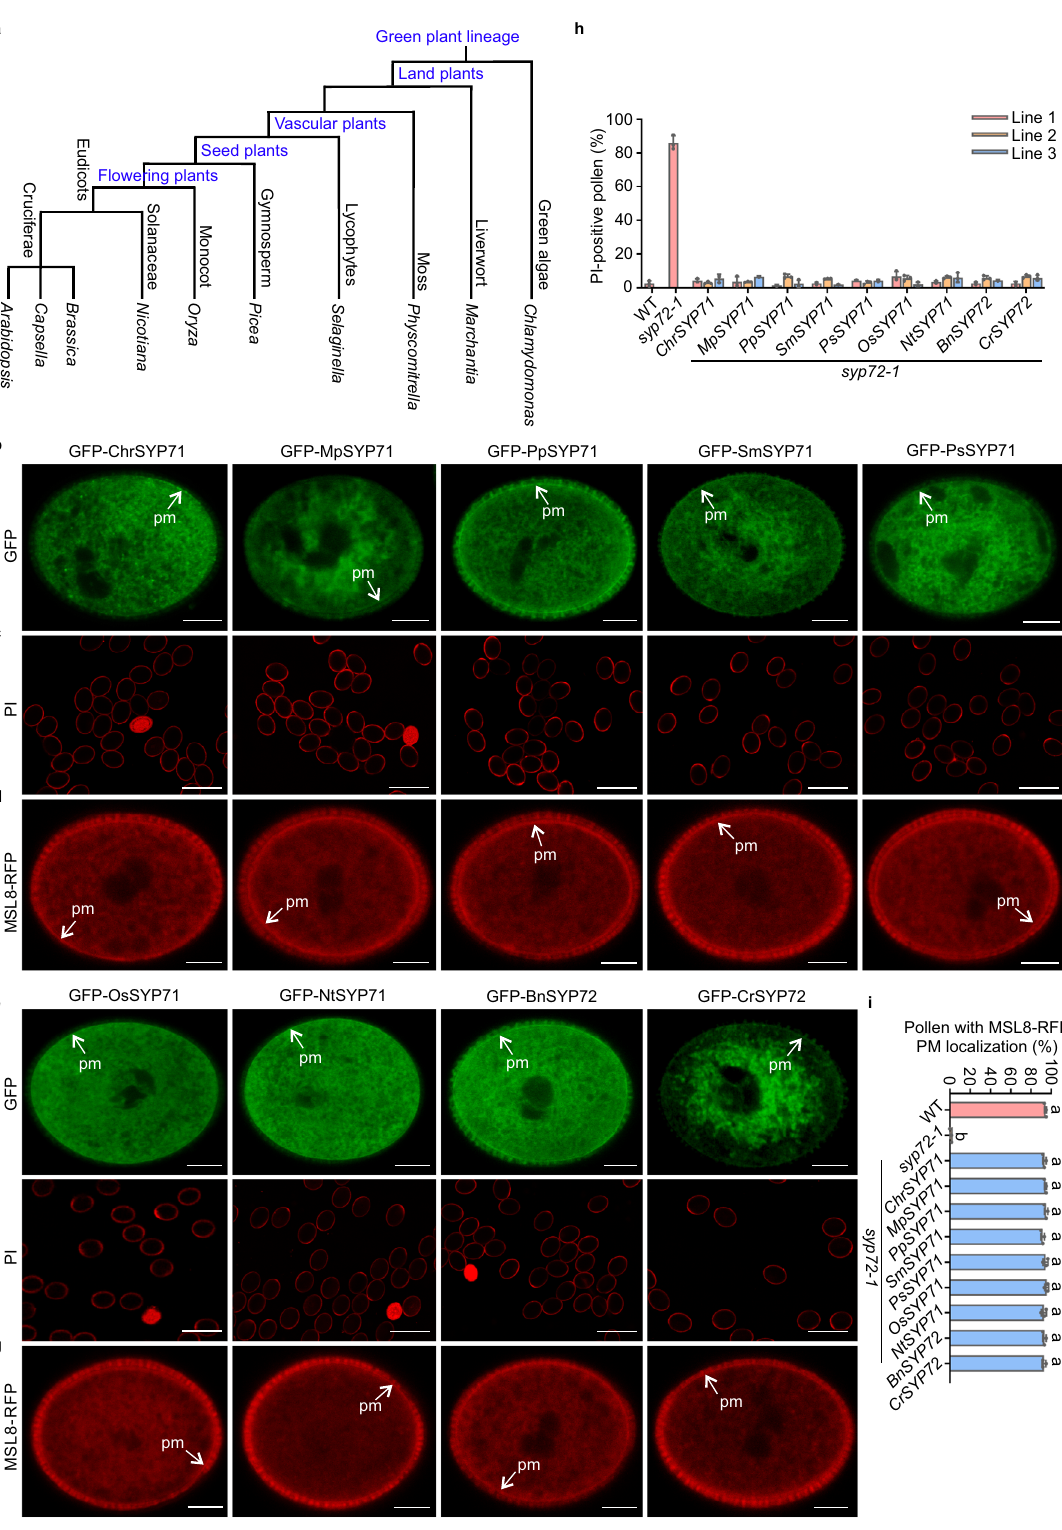
Yeast two-hybrid assay . A yeast two-hybrid membrane protein system was used to verify the interaction between SYP72 and MSL8. The coding regions of SYP52 and SYP72 were cloned into the pPR3-N, whereas the coding regions of MSL8 and MSL9 were cloned into the pBT3-C. Yeast transformation and growth assays were performed according to the manufacturer ’ s instructions (Dualsystem Biotech). Primer sequences for vector construction are listed in Supplementary Table